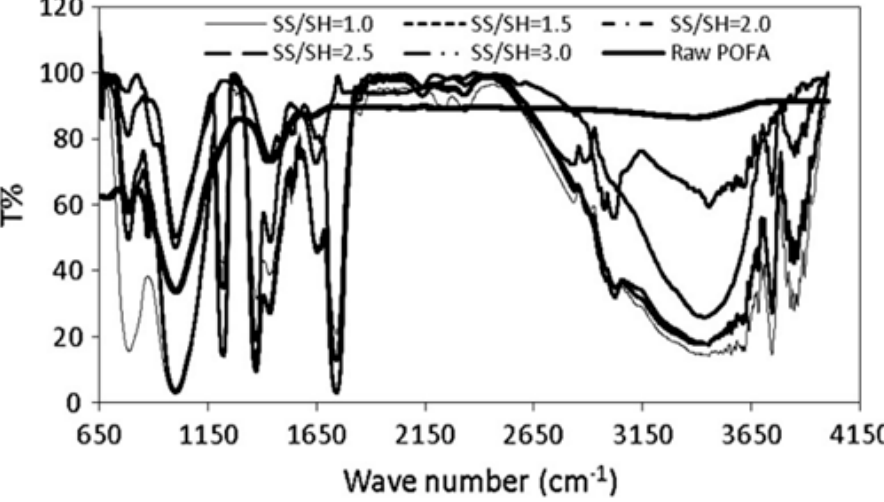
Figure 23. FTIR spectra of raw geopolymerized